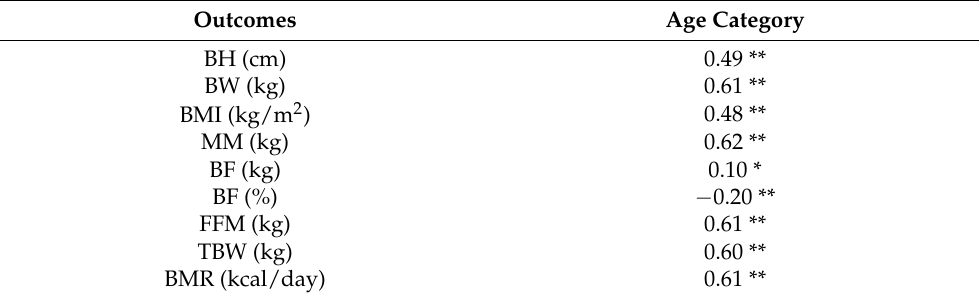
Table 2. Correlation between study outcomes and age